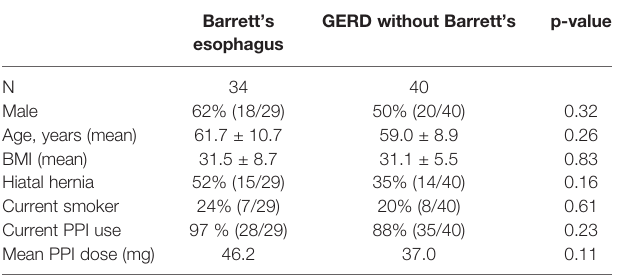
TABLE 1 | Cohort demographics*.